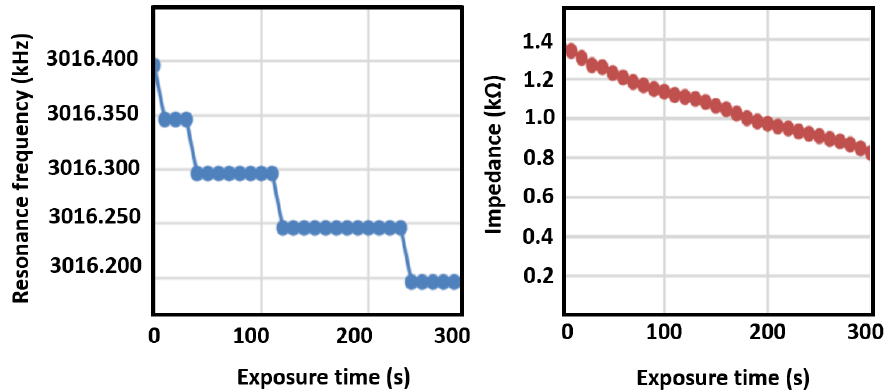
Figure 10 . Changes in quartz crystal microbalance resonance frequency and impedance upon expo- sure to ethanal.